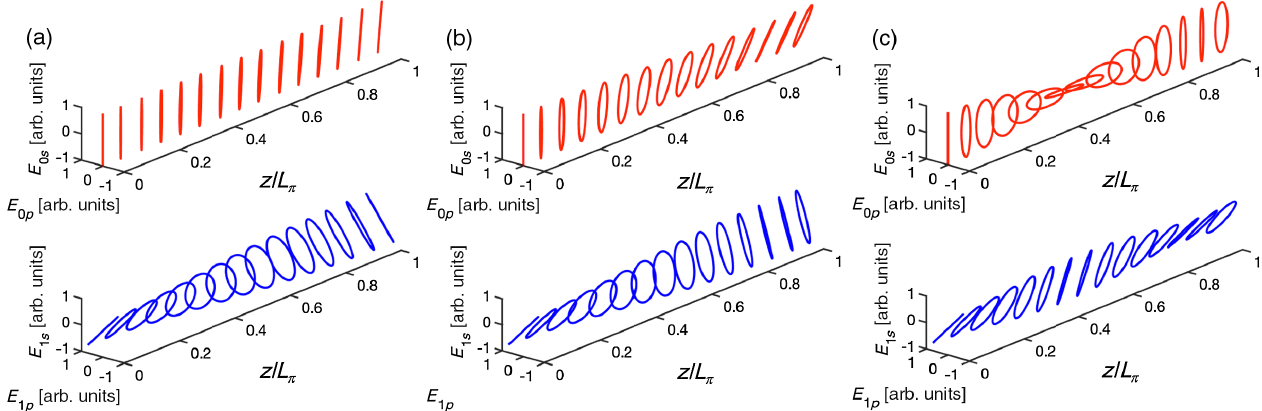
FIG. 2. Transition from linear to nonlinear polarization mixing in 1D for the simple case of a “ wave plate ” with the auxiliary E 0 initially s polarized and the probe linearly polarized at 45°, for ψ ¼ 10 ° and (a) I 1 ¼ 0 . 1 I 0 , (b) I 1 ¼ 0 . 5 I 0 , (c) I 1 ¼ 2 I 0 . The upper (lower) plots represent the auxiliary ’ s (probe ’ s) polarization state versus z .